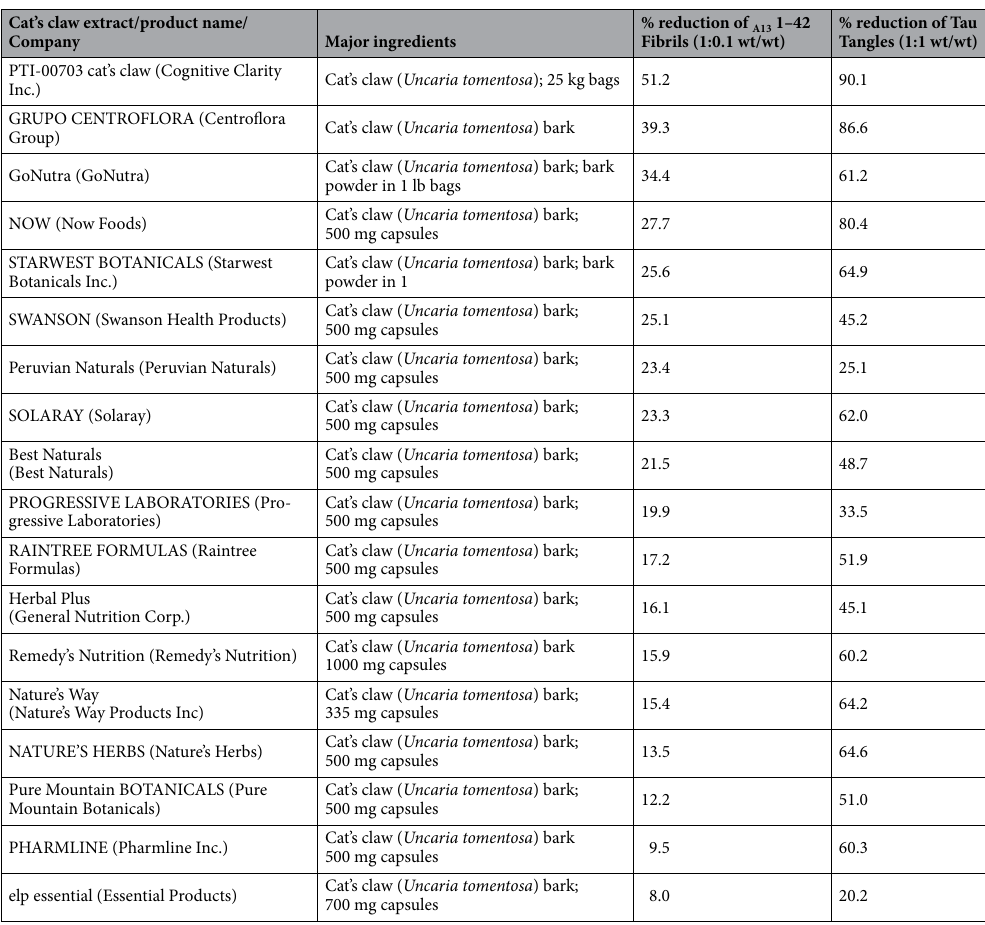
Table 2. Comparison of 18 cat’s claw extracts from different manufacturer’s for reduction of Aβ 1–42 fibril and/or tau tangles. Major ingredient details are also compared for each